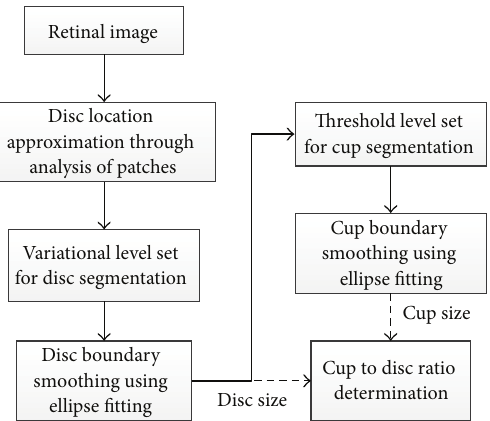
Figure 34: Flowchart for algorithm proposed in [58].